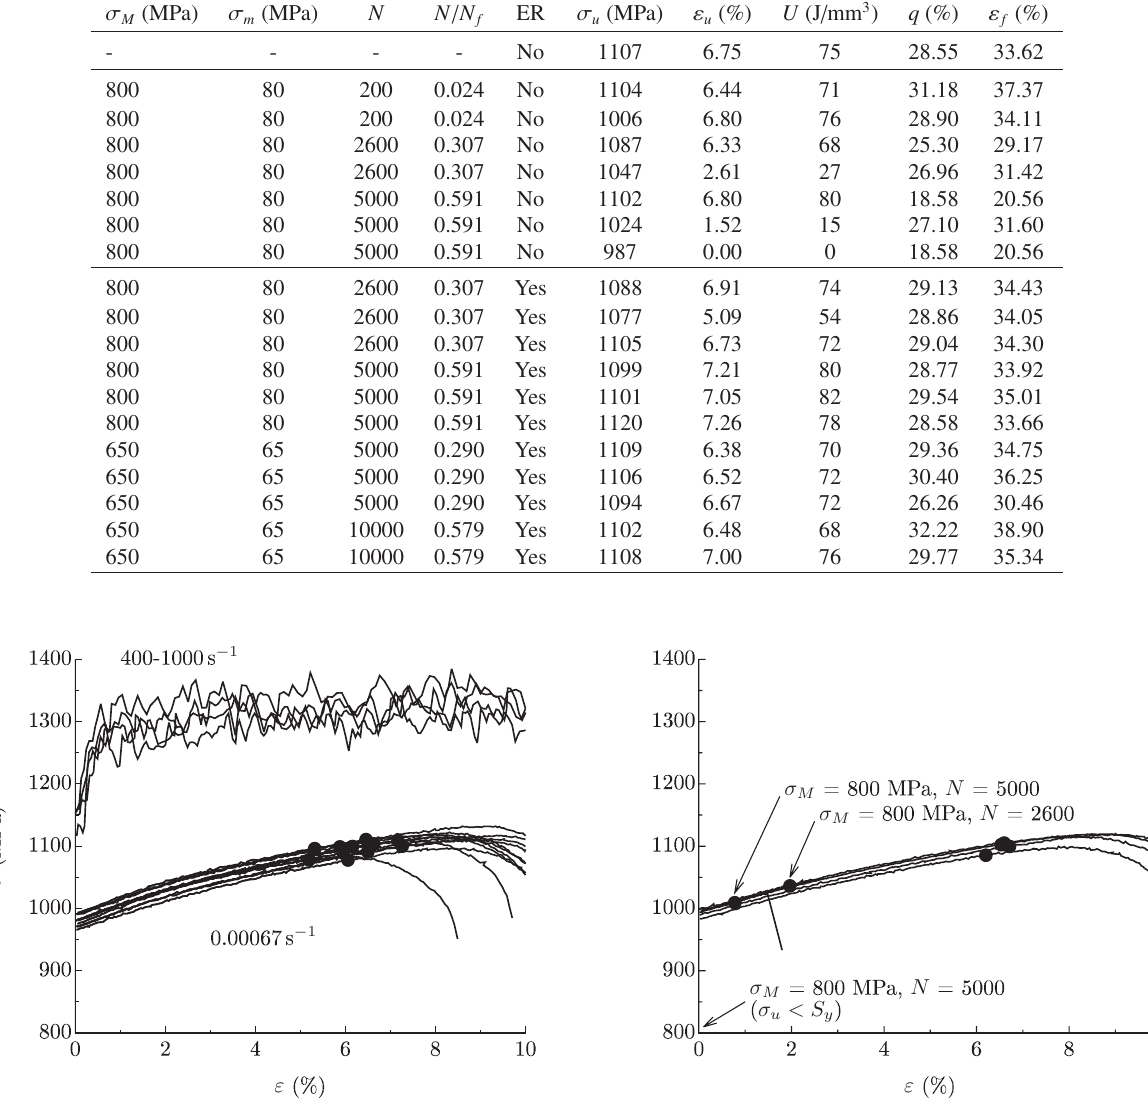
Fig. 8. True tensile diagram of previously fatigued material at di ff erent strain rates with edge removal (left) and without it